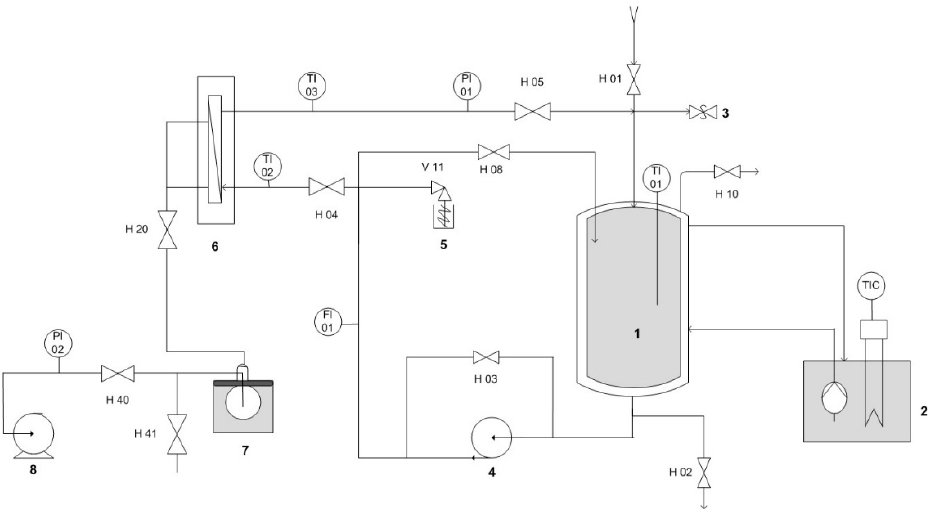
Figure 2. Pervaporation setup.